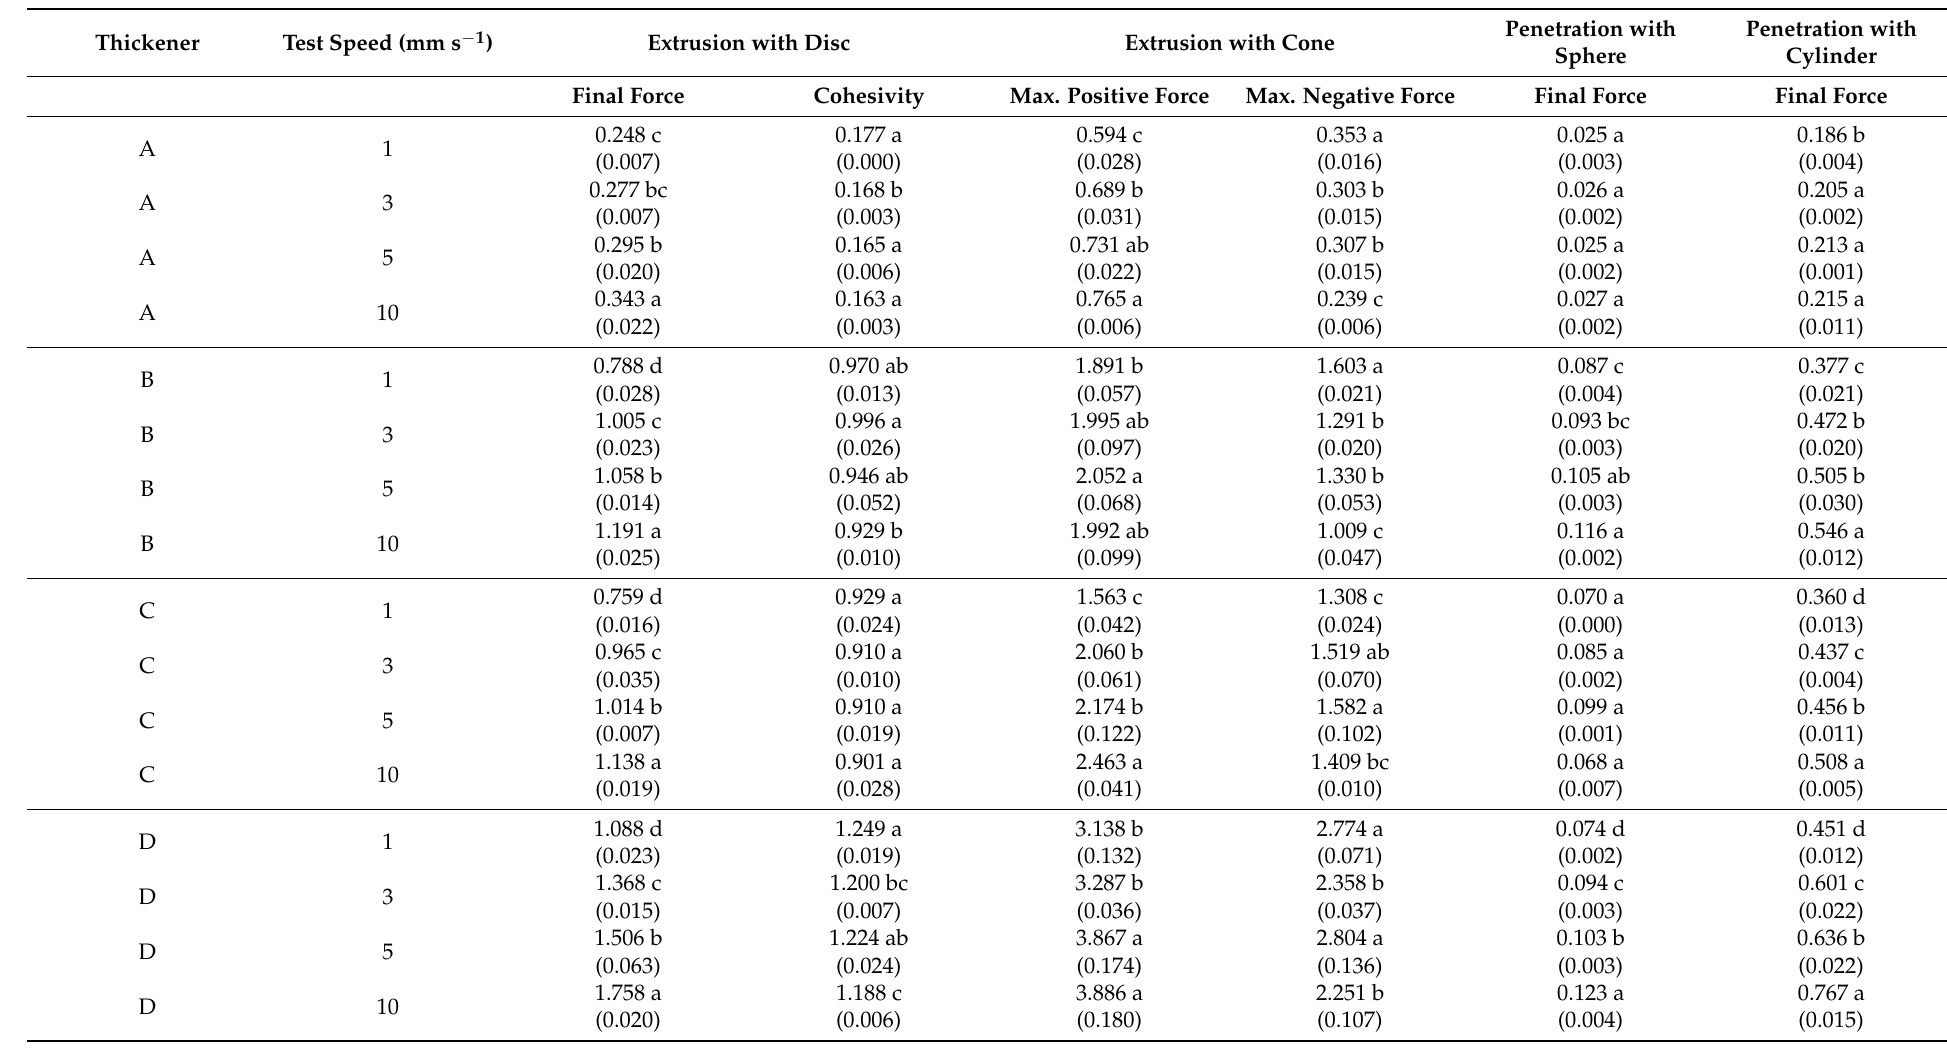
Table 7. Registered forces (in N) at different speeds for each thickener at pudding level for extrusion and penetration tests.